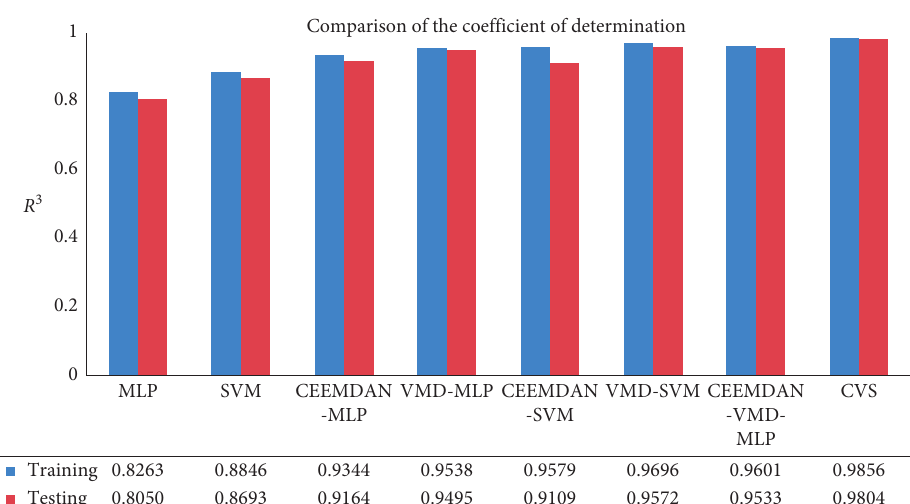
Figure 14: Comparison of the coefficient of determination of CVS with other